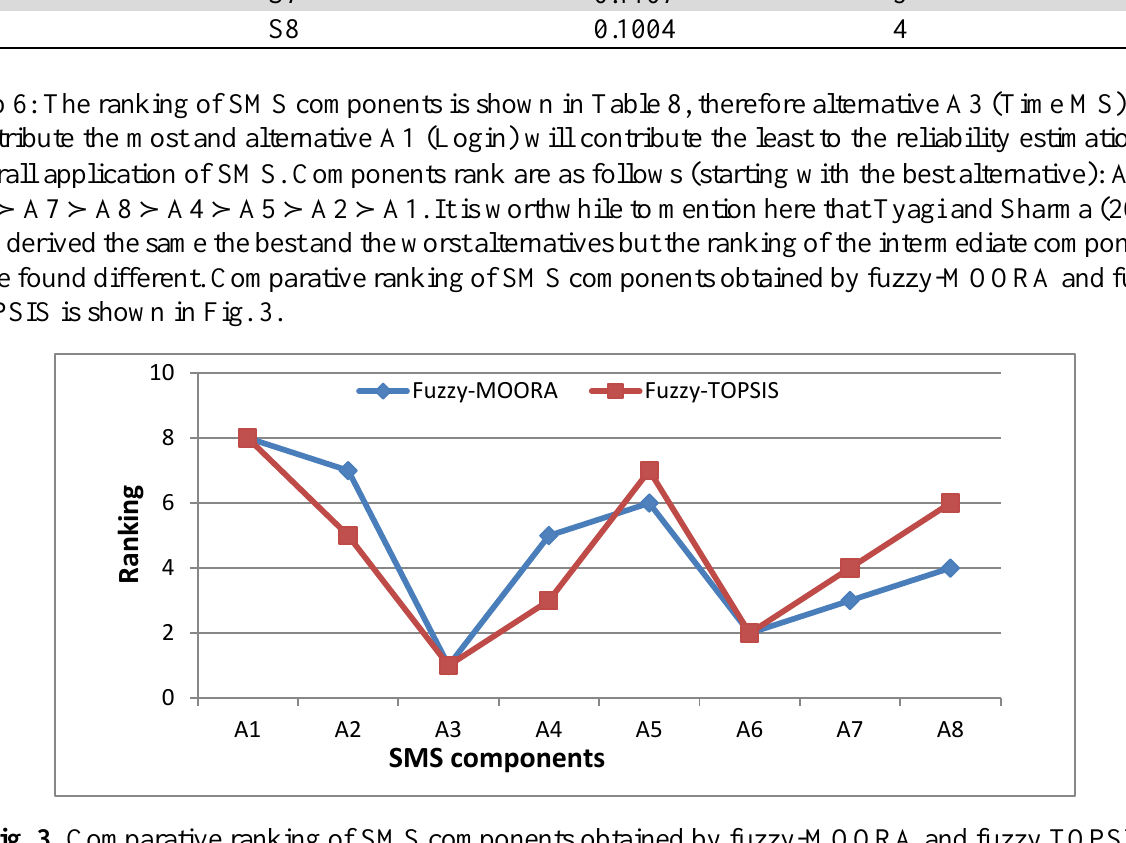
Fig. 3. Comparative ranking of SMS components obtained by fuzzy-MOORA and fuzzy